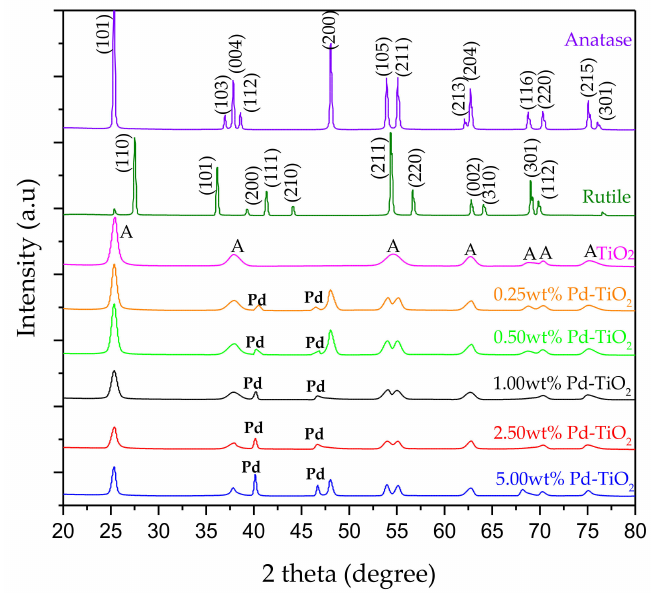
Figure 1. X-ray Di ff ractograms for Pd-Doped TiO 2 Photocatalysts. XRDs for A = anatase and Pd = palladium are shown as a